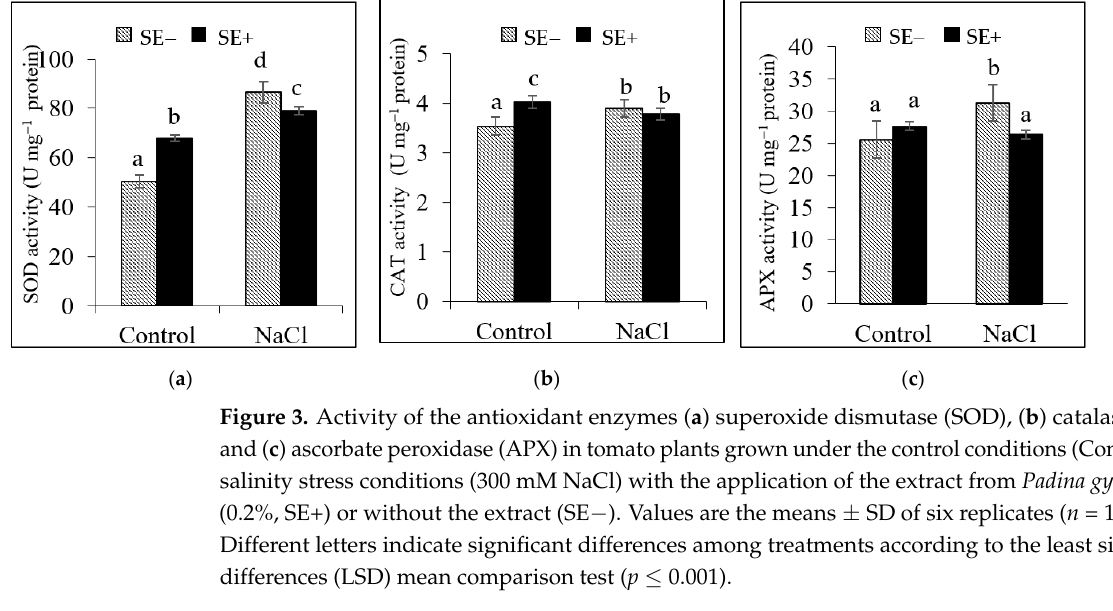
Figure 3. Activity of the antioxidant enzymes ( a ) superoxide dismutase (SOD), ( b ) catalase (CAT), and ( c ) ascorbate peroxidase (APX) in tomato plants grown under the control conditions (Control) and salinity stress conditions (300 mM NaCl) with the application of the extract from Padina gymnospora (0.2%, SE+) or without the extract (SE − ). Values are the means ± SD of six replicates ( n = 12 plants). Different letters indicate significant differences among treatments according to the least significant differences (LSD) mean comparison test ( p ≤ 0.001).